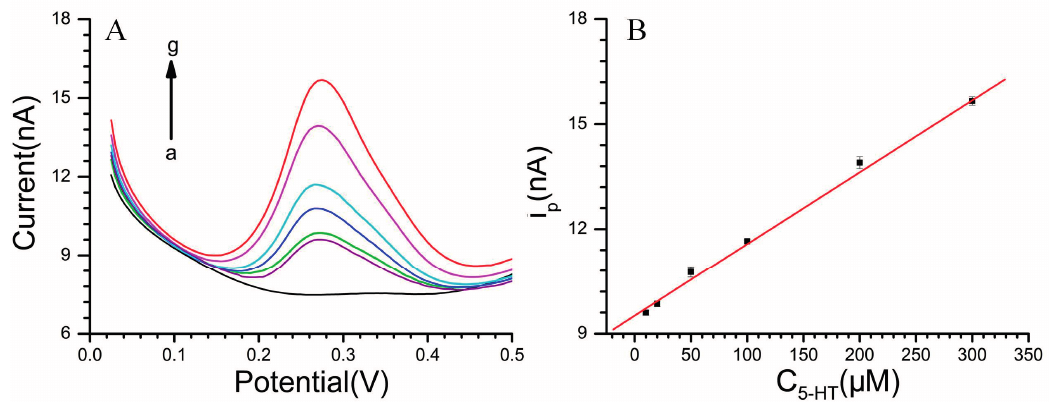
Figure 5. ( A ) DPVs of DA, DA concentration (a–g): 0 to 2 × 10 − 4 M; ( B ) The linear relationship between the DA concentration with the oxidation peak current. Solution: pH 7.4 phosphate buffer.